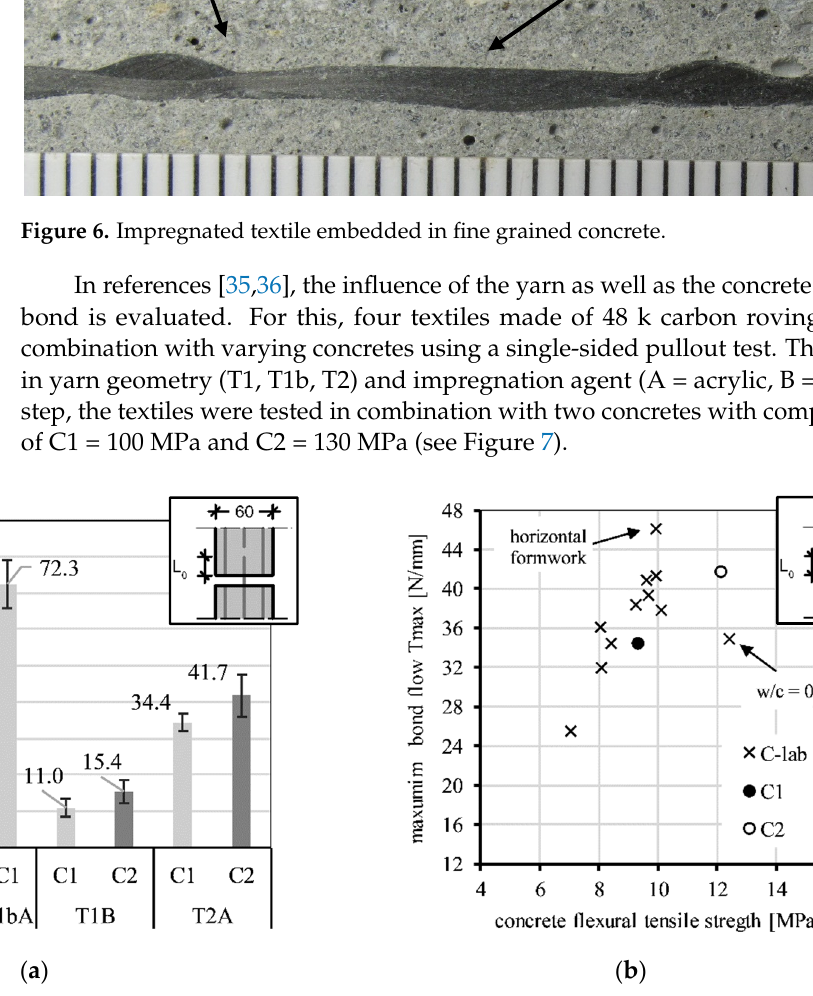
Figure 7. Influence of the yarn and concrete characteristics on the maximum bond flow tested in a single-sided pullout test: ( a ) textile geometries T1, T1b and T2; impregnation agents: A = acrylate, B = SBR; concretes C1 (fc,m = 100 MPa) and C2 (fc,m = 130 MPa); ( b ) tests performed with T2A and various concretes, adapted from [35,36].